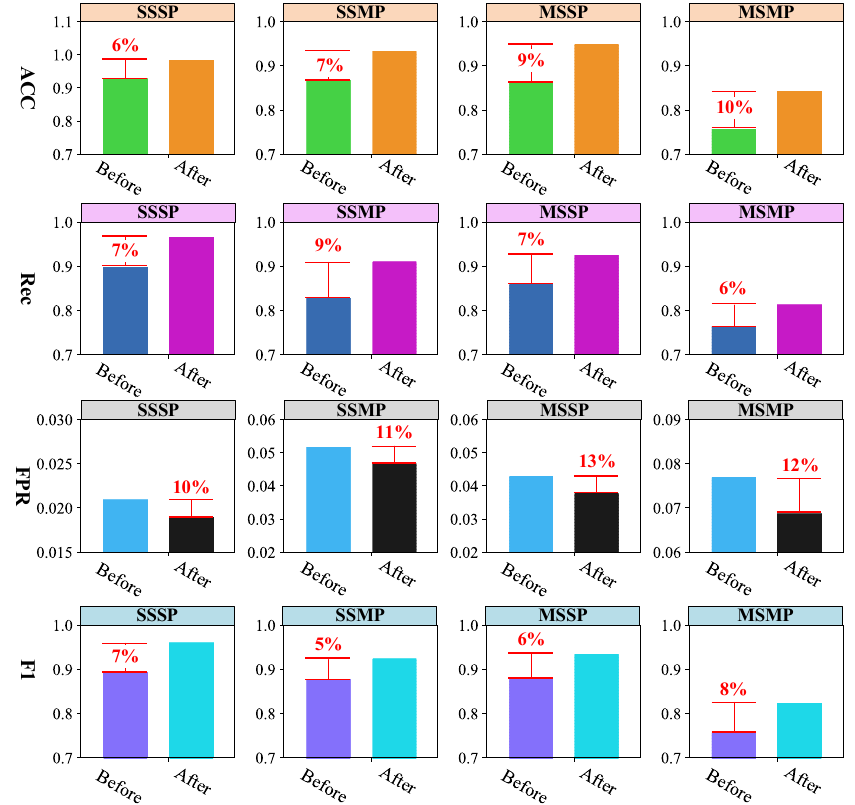
Figure 8. Performance analysis of two optimization strategies on SWaT dataset.